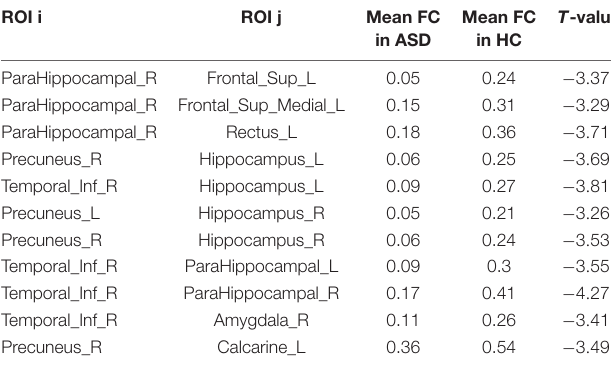
TABLE 3 | Subnetworks with decreased FC in the ASD group relative to the HC group ( p =